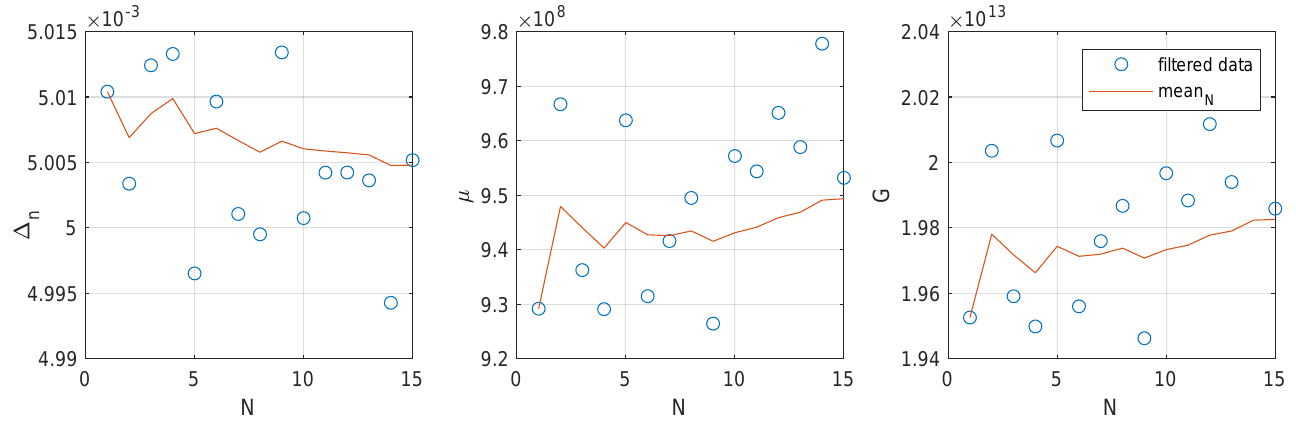
Figure 14. Evolution of the three optimization variable means for N Monte-Carlo realizations.